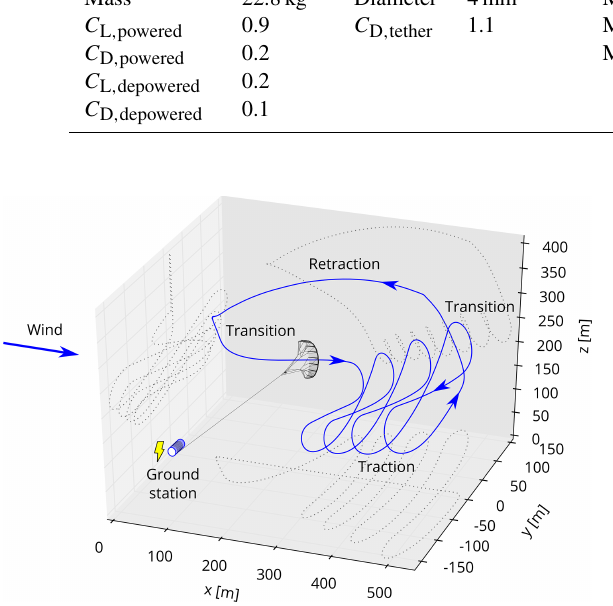
Figure 17. Flight path of the flexible-kite, pumping AWE system (kite and drum not to scale) adapted from Fechner (2016).